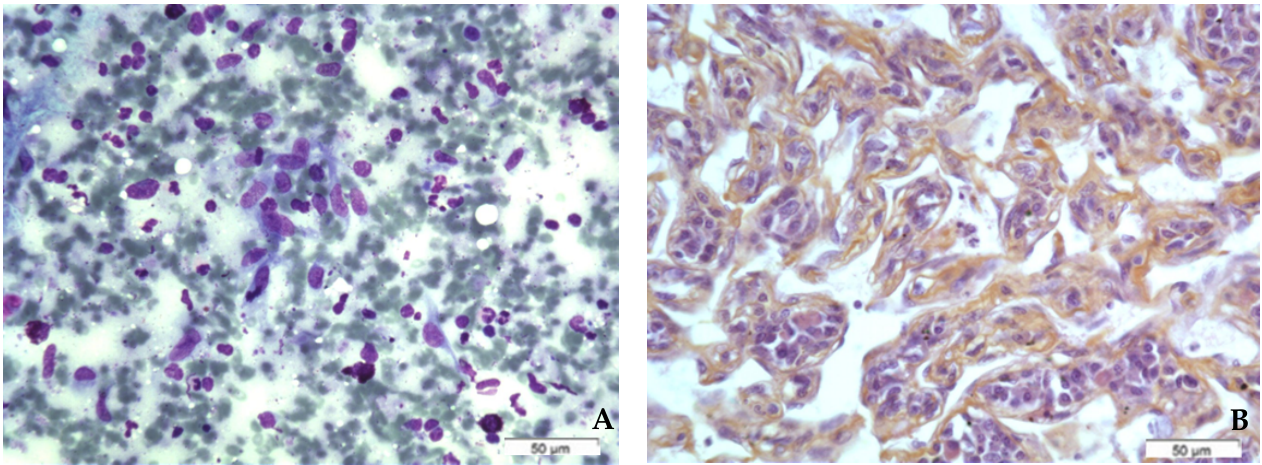
Figure 3. The same case of radiation-induced breast angiosarcoma from the Figure 2. ( A ): cytologic smears showing numerous spindle-shaped sarcomatous cells exhibiting mild cyto-nuclear pleomorphism. Note the presence of naked nuclei and hemorrhagic background (May-Grunwald– Giemsa 400 × ; Merck, Darmstadt, Germany). ( B ): Corresponding surgical sections showing typical angiosarcoma rich in vascular spaces bordered by spindle-shaped sarcomatous cells (Hematoxylin- Eosin-Safran, 400 × ; Merck, Darmstadt,